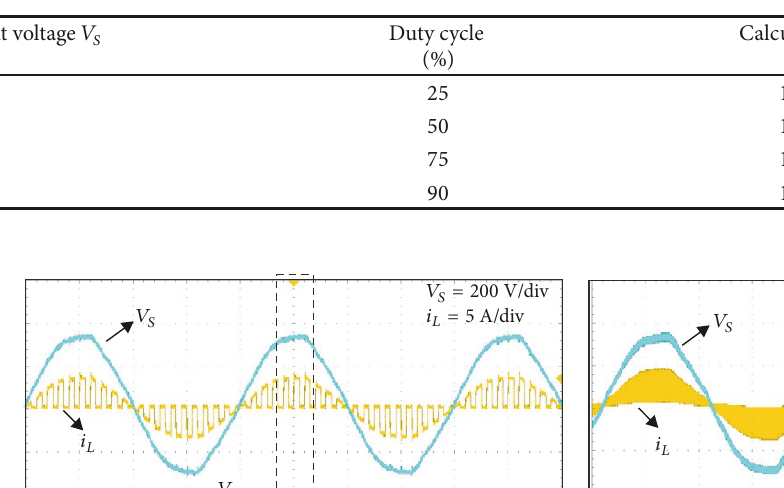
Table 4: Data of the ac voltage regulator circuit at 𝐹 𝑆𝑊 = 100 kHz.